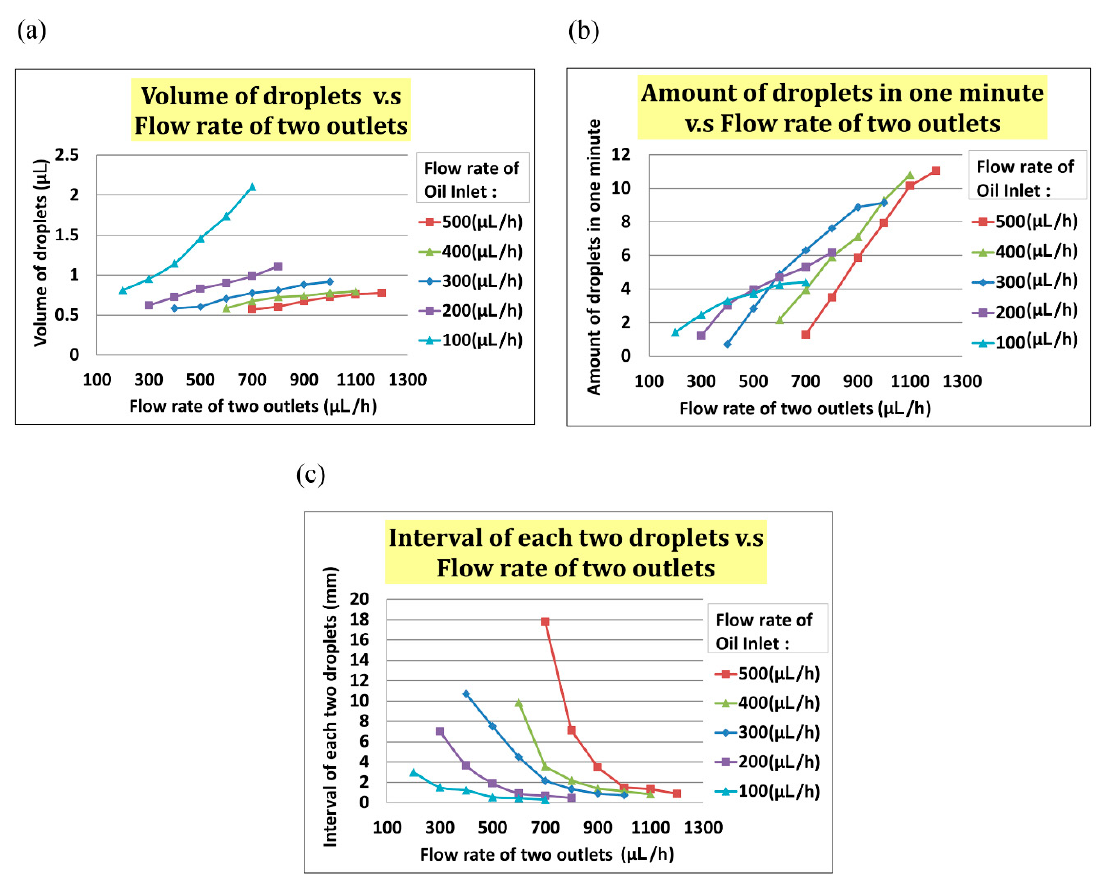
Figure 5. ( a )The volume of a droplet increased when the total flow rate of the two outlets increased. ( b )The frequency of droplet generating increased when the total flow rate of the two outlets increased. ( c )The interval between two droplets increased when the total flow rate of the two outlets increased.